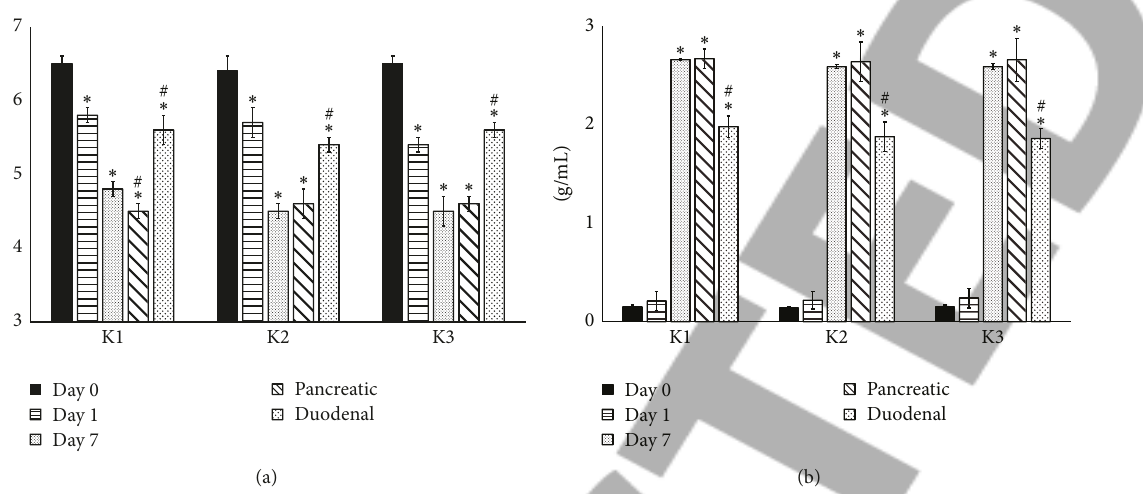
Figure 1: Changes in the (a) pH and (b) titratable acidity values of the three Kombucha beverages. Error bars represent the SEM. ∗ 𝑃 < 0.05 versus the value at day 0. # 𝑃 < 0.05 versus the value at day 7 (prior to being subjected to the digestion